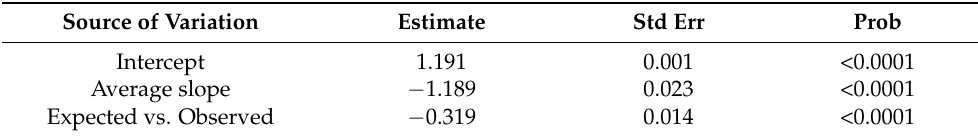
Table 3. Results of the ANCOVA test performed on the expected and observed bulk density values of the six soil–biochar